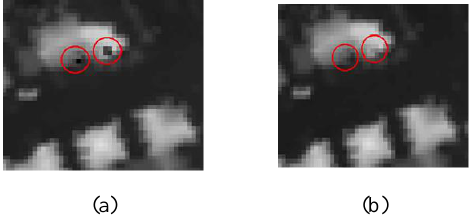
Figure 4. The result of the algorithm in single outlier: (a) Before (b)